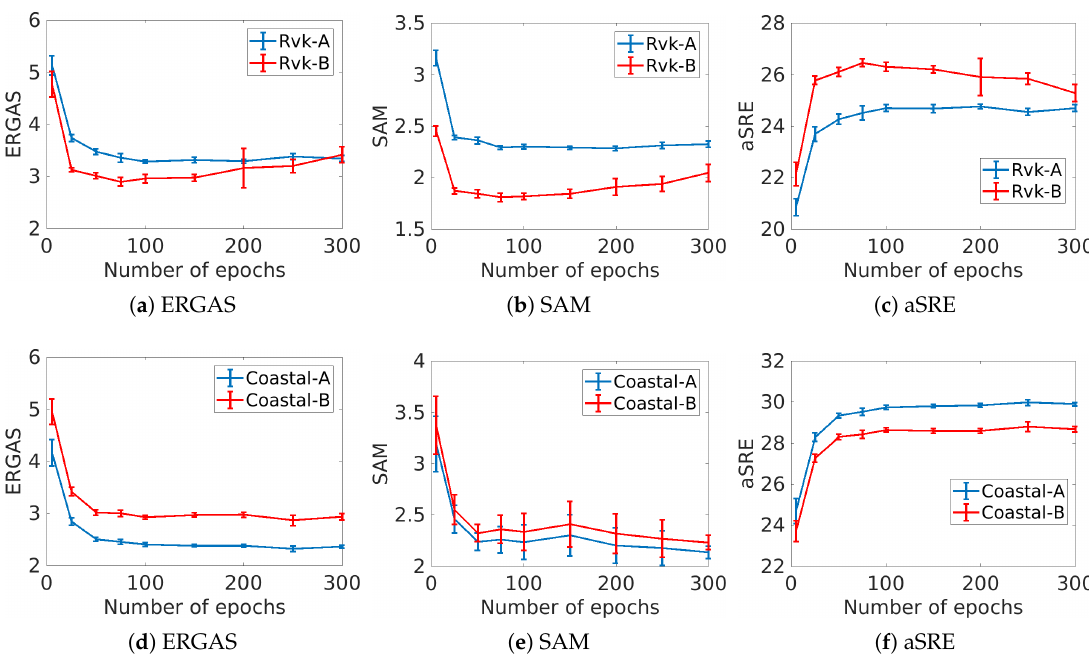
Figure 6. Values of the quality evaluation metrics as a function of the number of training epochs for the Coastal and urban Rvk datasets. The network was trained on the A image and tested on A and B. aSRE is the average SRE of the bands and is given in dB and SAM is given in